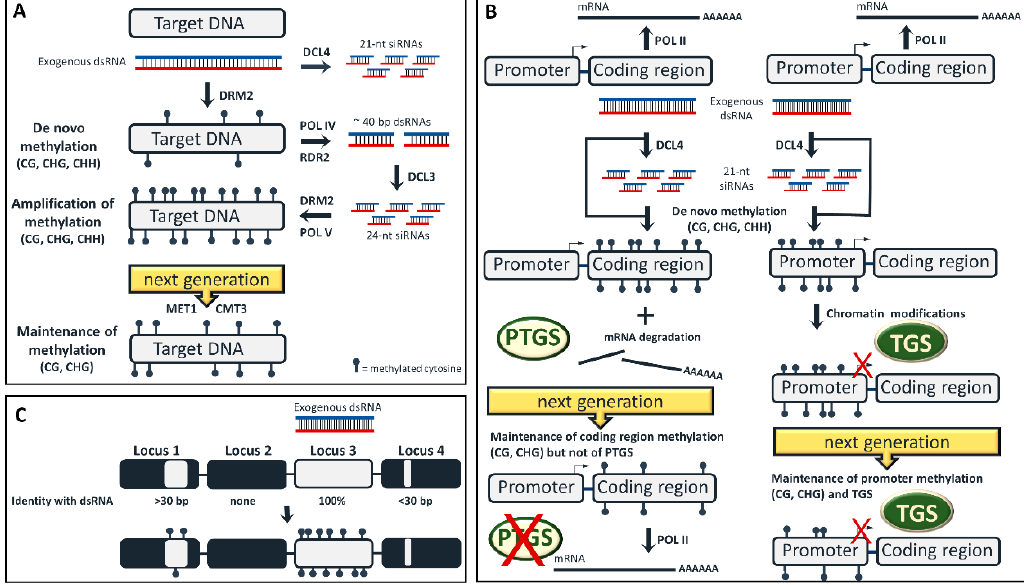
Figure 1. Epigenetic modifications upon exogenous RNA interference (exo-RNAi) application. (A) The three steps of DNA methylation: de novo , amplification and maintenance. Exogenously applied double-stranded RNAs (dsRNAs) are mainly processed by dicer-like 4 (DCL4) into 21-nt short-interfering RNAs (siRNAs) that have no direct role in RNA-directed DNA methylation (RdDM) in the nucleus, but they mediate post-transcriptional gene silencing (PTGS) in the cytoplasm. According to our hypothesis, the exogenous long dsRNA triggers the first incomplete wave of de novo methylation, while the 24-nt siRNAs,that are subsequently generated upon RNA polymerase IV (POLIV) transcription of the de novo methylated locus, are seemingly involved in the amplification of these methylation marks. Thus, both long dsRNAs and 24-nt siRNAs are able to recruit domains rearranged methyltransferase 2 (DRM2) to their target in a stepwise manner. In the absence of RdDM trigger molecules (dsRNA or siRNAs) CHH methylation is mitotically/meiotically lost, while CG and CHG methylation are maintained by methyltransferase 1 (MET1) and chromomethylase 3 (CMT3), respectively. (B) Exogenous application of dsRNA designed to target a coding region (left) will result not only to mRNA degradation aPTGS, but also to RdDM of the coding region. In the next generation, PTGS will be lost, but DNA methylation (CG and to lesser extent CHG) will be maintained. Exogenous application of dsRNA designed to target a promoter (right) will lead to promoter RdDM. Should additional chromatin modifications occur, TGS will also take place. In the next generation, CHH methylation will be lost, but CG/CHG methylation and TGS will be maintained. (C) A dsRNA may trigger RdDM not only to a DNA sequence which shares full sequence identity (locus 3, on-target), but also to an unrelated DNA sequence exhibiting a minimum of 30-bp sequence identity with the dsRNA (locus 1, off-target).